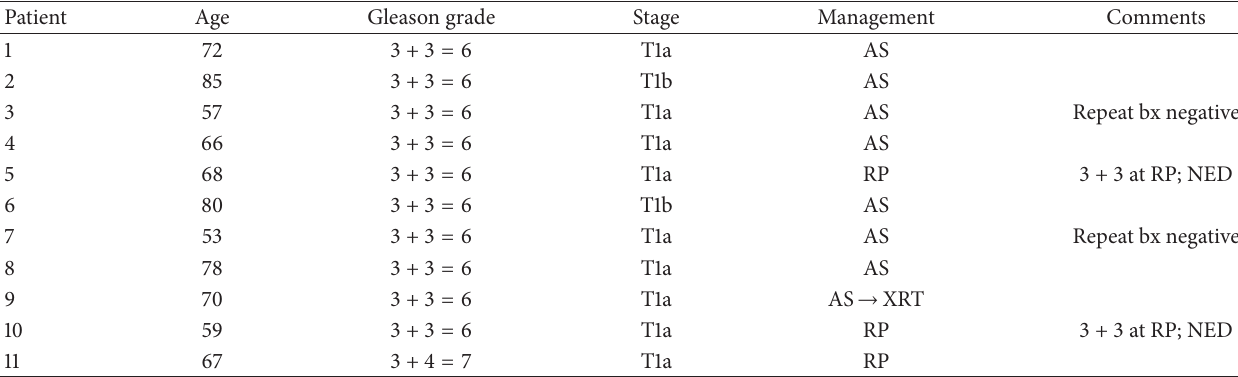
Table 1: Incidental prostate cancer patient